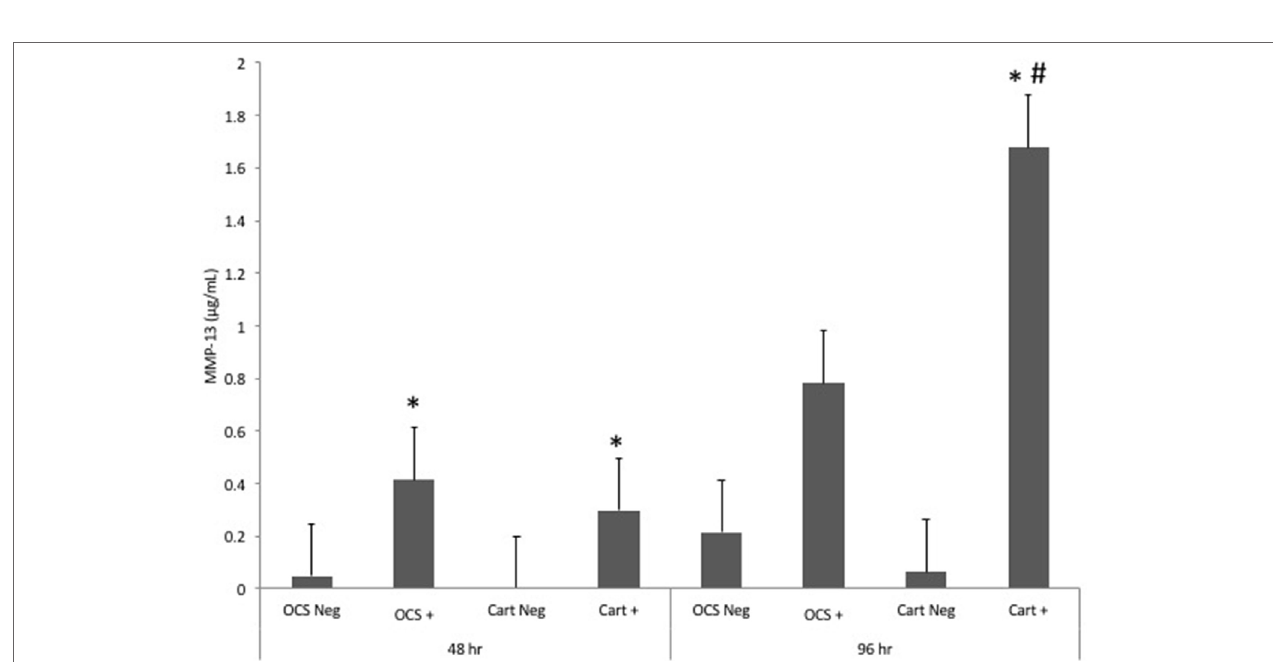
FigUre 3 | Mean ± SE concentrations of matrix metalloproteinase-13 (MMP-13) in media samples of cultures containing osteochondral and synovial explants (OCS) or cartilage explants alone (Cart) that were unstimulated (Neg) or stimulated with IL-1 (10 ng/mL; + ) at 48 and 96 h after initiation of treatments.